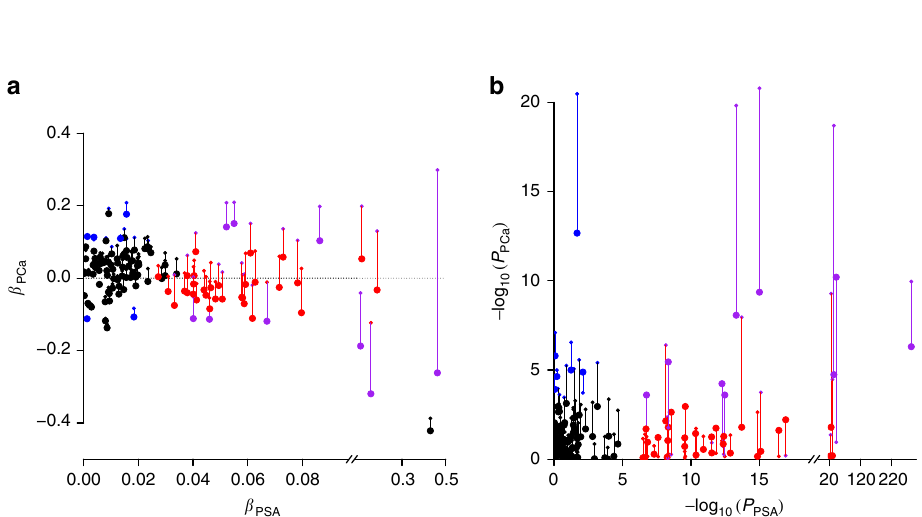
Figure 3 | Comparison of the effect of SNPs on PSA levels versus on prostate cancer (PCa) in KP non-Hispanic whites. Results are from separate models regressing PSA level (linear regression) or PCa (logistic regression, unadjusted for PSA levels are small circles, adjusted for PSA levels are large circles) on each of the 40 PSA level SNPs from Tables 2 and 3 and the 105 previously identified PCa SNPs. ( a ) Effect sizes. ( b ) P values. Red points are associated with PSA levels only (from Tables 2 and 3), blue with PCa only ( P o 0.00125, a Bonferroni correction for 40 SNPs), purple with both PSA and PCa (for small circles, this also includes previously identified PCa associated SNPs), and black are previously identified PCa associated SNPs (not significant here). Previously reported PCa SNPs within 0.5Mb of a PSA SNP were removed: rs1775148, rs6763931, rs2242652, rs10486567, rs2928679, rs1512268, rs12543663, rs10086908, rs1016343, rs13252298, rs6983561, rs116041037, rs445114, rs16902104, rs6983267,